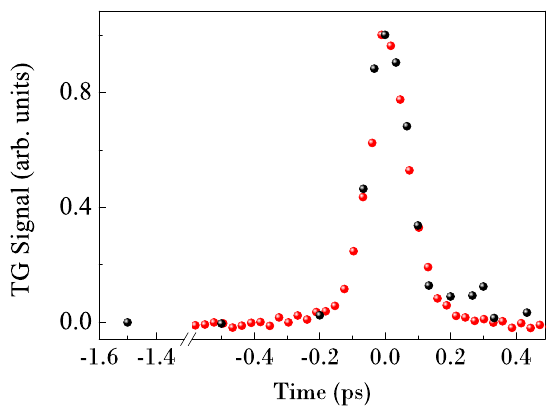
Figure 6. TG signal at short time on a vitreous SiO with EUV (black circles) and infrared (red circles) pump